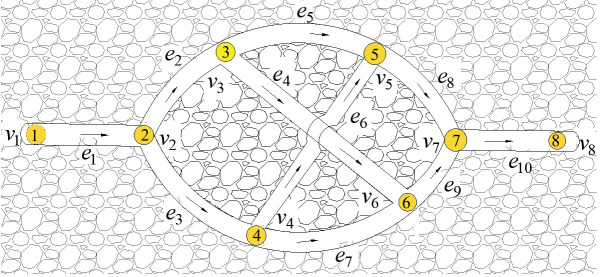
Three-dimensional network graph in [14].